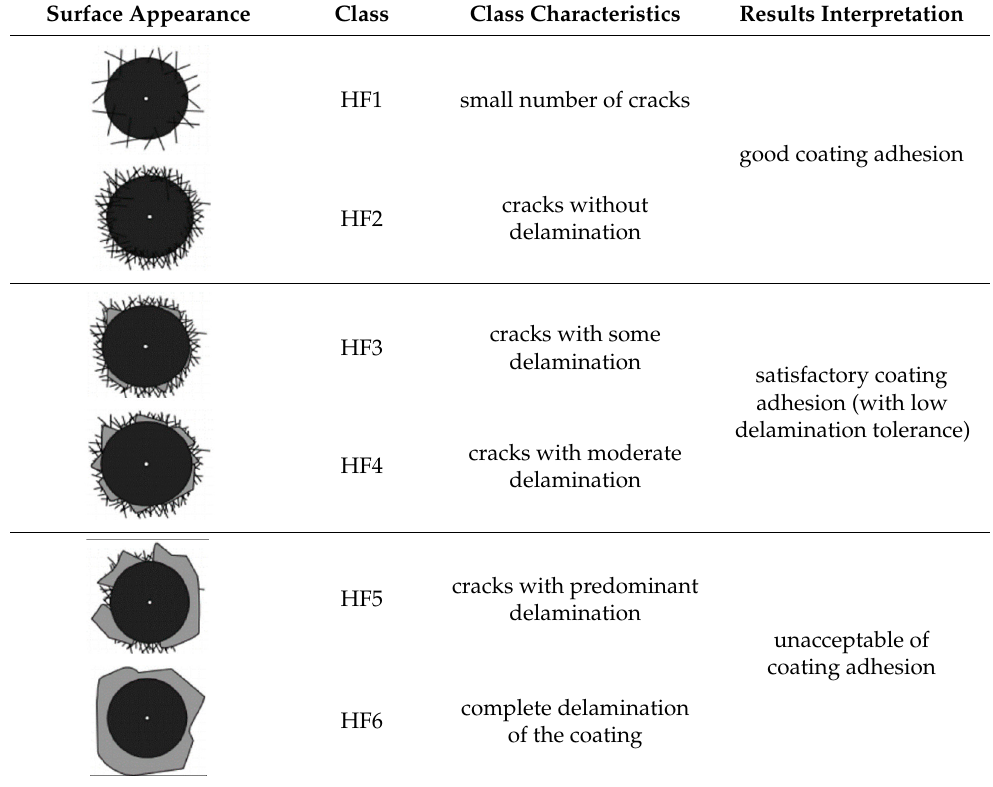
Table 12. Classification of the coating adhesion by the Rockwell method.